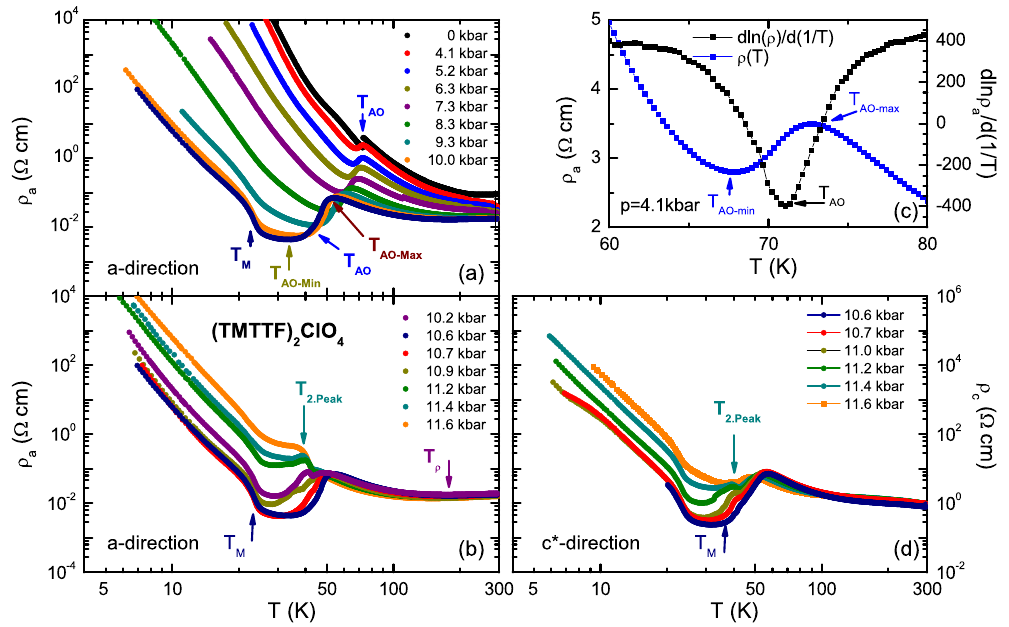
Figure 9. Pressure evolution of the temperature-dependent electronic transport of (TMTTF) 2 ClO 4 . ( a ) dc resistivity as a function of temperature for ambient conditions and for hydrostatic pressures up to 10.0 kbar measured along the stacking direction a . ( b ) For higher pressure values a more complex behavior of ρ a ( T , p ) is observed. ( c ) For the example taken at p = 4.1 kbar, we illustrate how the different parameters of the anion ordering transition were extracted from ρ ( T , p ) and its derivative with respect to inverse temperature 1/ T . ( d ) Temperature dependence of the perpendicular resistivity ρ c ( T , p ) for the high-pressure